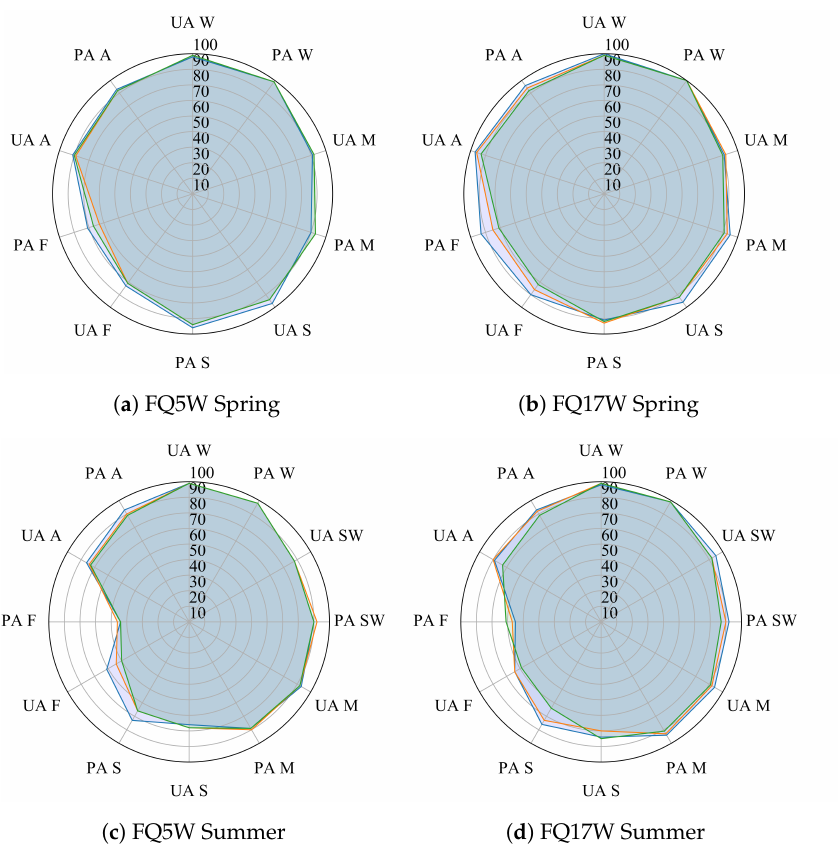
Figure 6. User’s (UA) and producer’s (PA) accuracies for water (W), shallow water (SW), marsh (M), swamp (S), forest (F), and agriculture/non-forested (A) for models based on single QP (blue), CP medium (orange), or CP high resolution (green) images and DEM and DSM